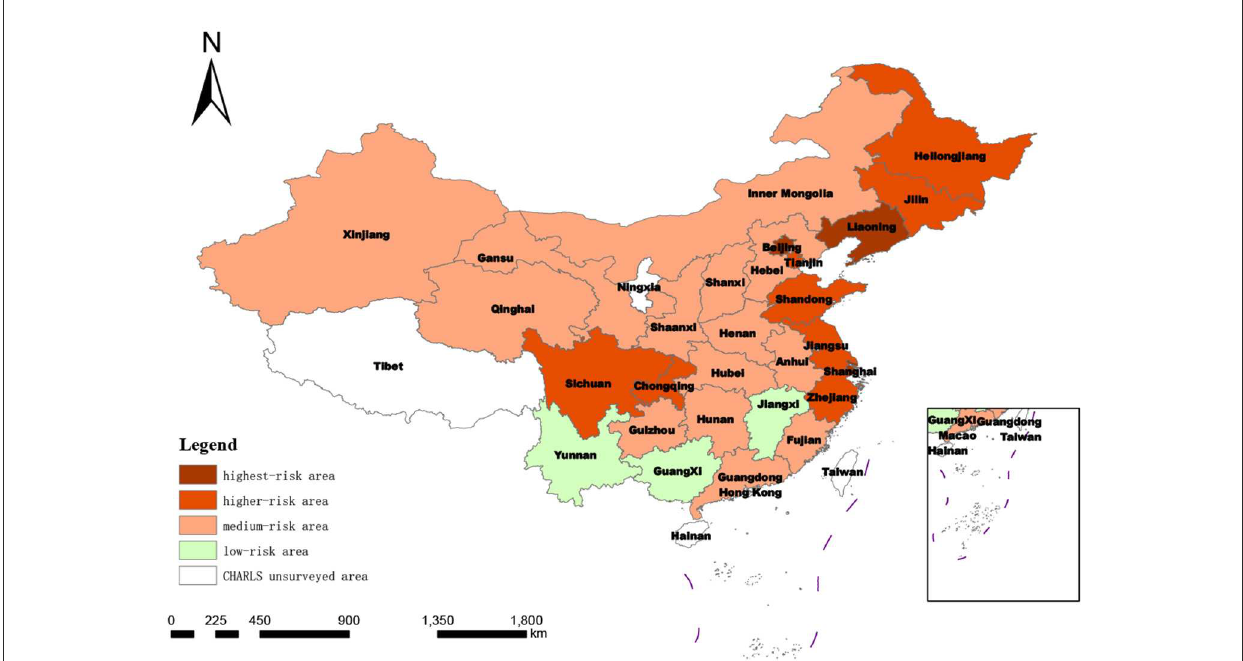
FIGURE4 Spatial distribution of degree of regional social disability risk according to macro-system score.